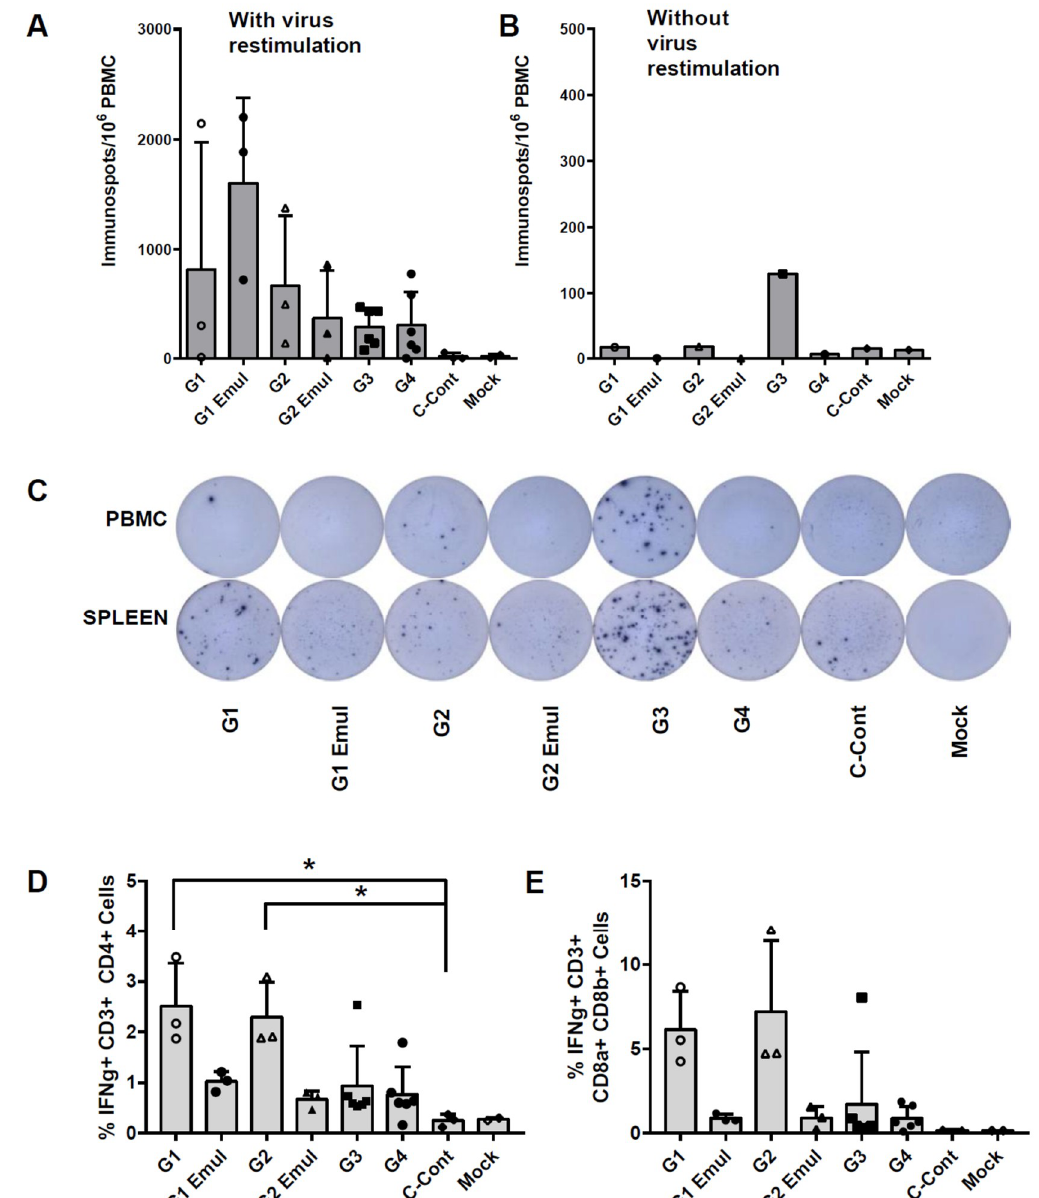
Figure 6. T cell responses at 5 days post challenge. ( A ) IFNγ ELISPOT with PBMCs of individual animals restimulated over night with pH1N1 virus. ( B ) IFNγ ELISPOT with pools of PBMCs that were left over night without restimulation to estimate background levels of IFNγ secretion. ( C ) Images of ELISPOT wells of pooled PBMCs or splenocytes left over night without virus restimulation. ( D ) Percentage of IFNγ+ CD4+ T cells in PBMCs after 8 h of pH1N1 virus restimulation. ( E ) Percentage of IFNγ+ CD8a+ CD8b+ T cells in PBMCs after 8 h of pH1N1 virus restimulation. Bars represent means and error bars represent standard deviations. Open and filled symbols ( △ , □ and ○ ) were used to show individual data points for the different experimental groups. * indicates statistical significant differences between the tested groups ( p < 0.05) as measured by Dunn’s multiple comparisons test performed after a Kruskal-Wallis test.